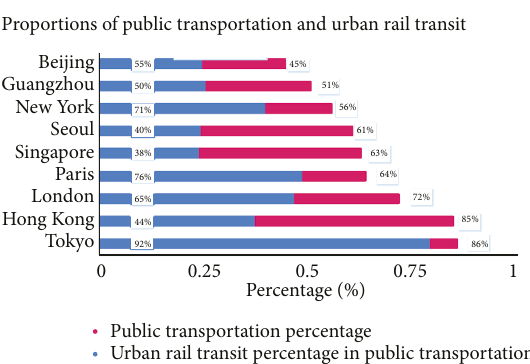
Figure 1: Proportions of public transportation and urban rail transit.